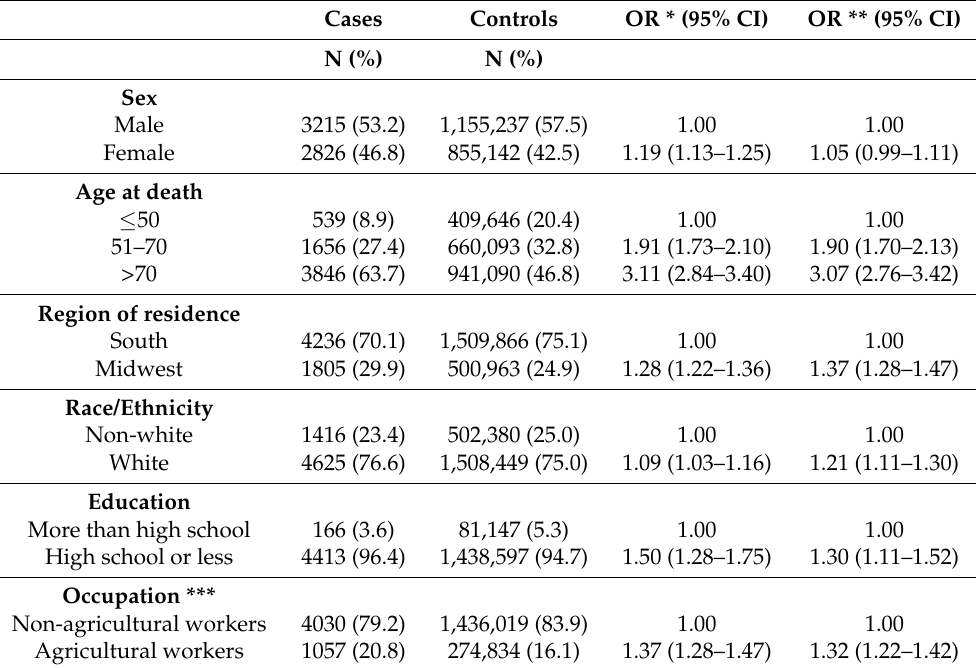
Table 1. Characteristics of AKF cases and controls, based on death certificates for southern and midwestern Brazilian states from 2006 to